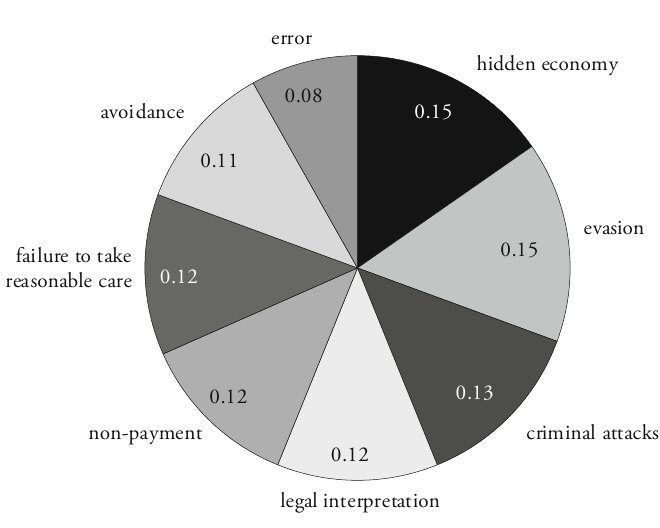
Figure 4: Breakdown of the United Kingdom Tax Gap 2011–12 by